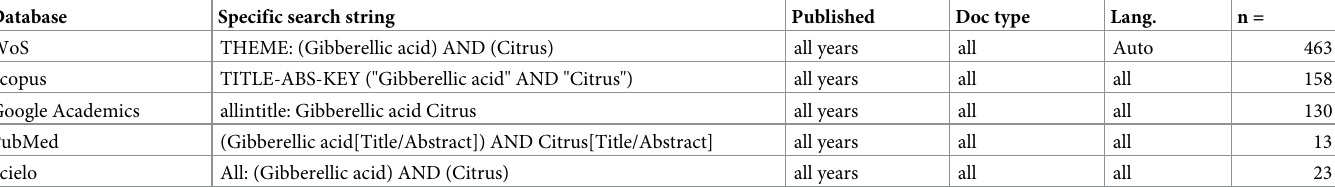
Table 2. Electronic search